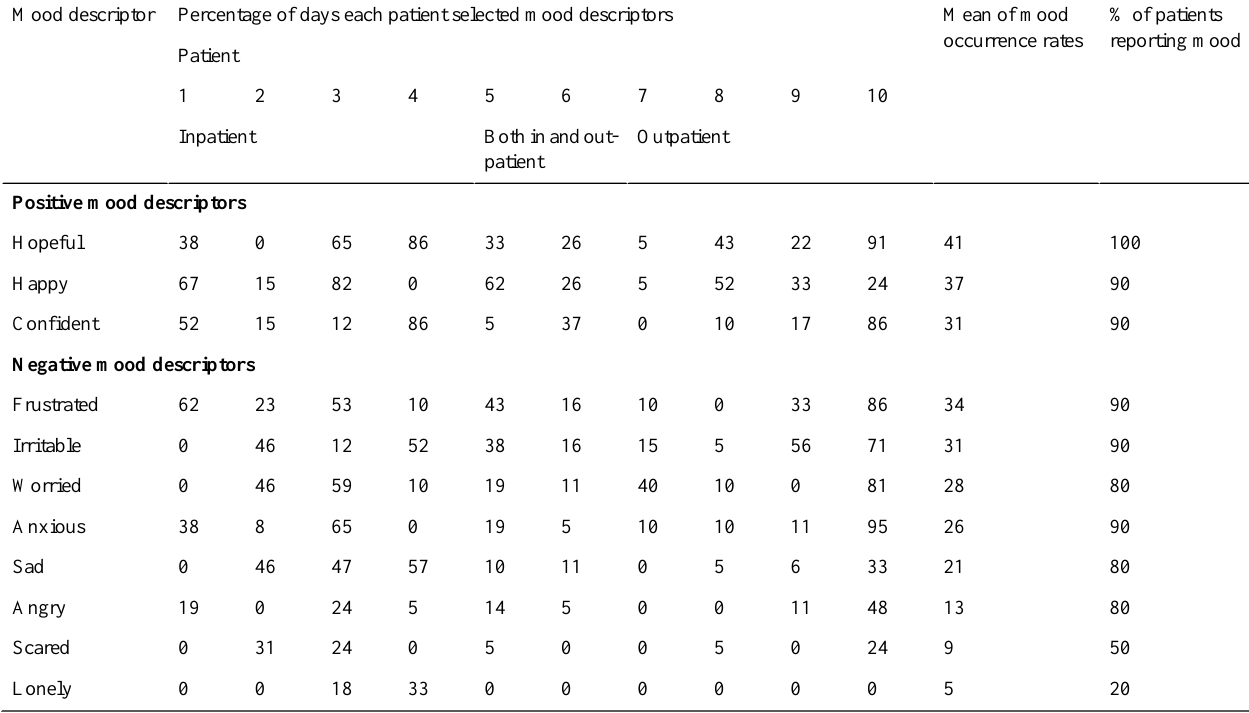
Table 4. Patients’selection of mood descriptors.